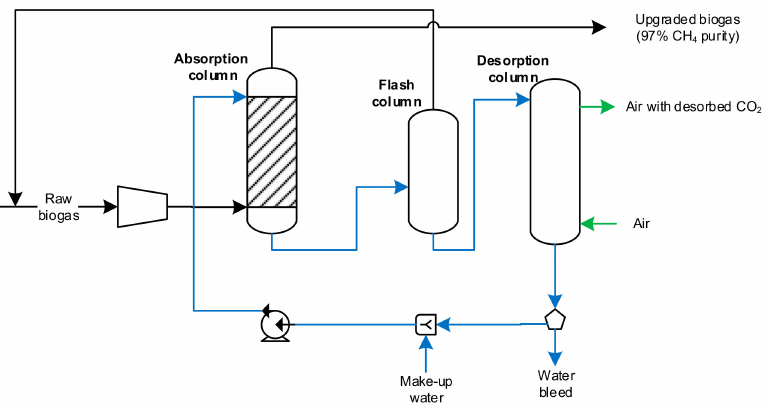
Figure 5. Biogas upgrading with water scrubbing. Adapted from Muñoz et al.